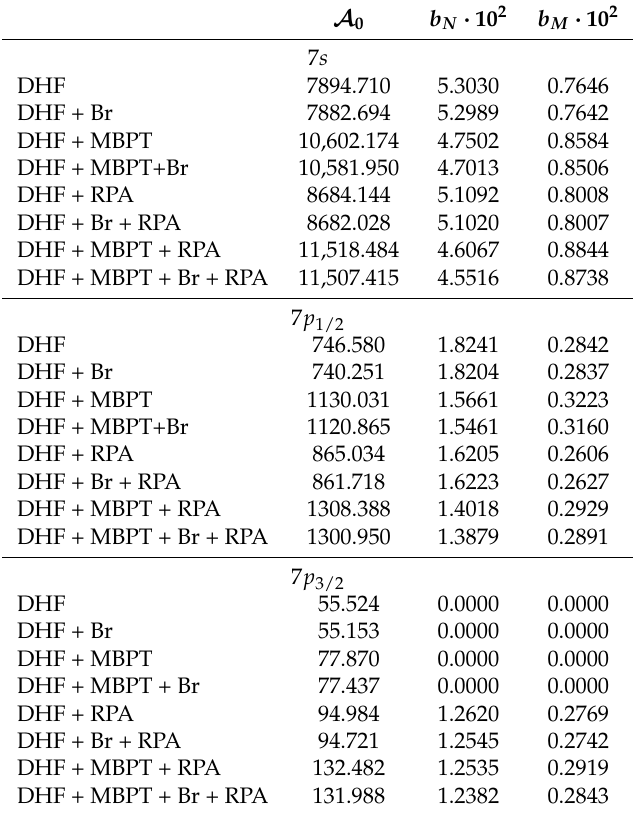
Table 2. Calculated parameters A 0 (MHz), b N and b M ( fm 1 − 2 γ ) for the neutral Fr atom on a different levels of